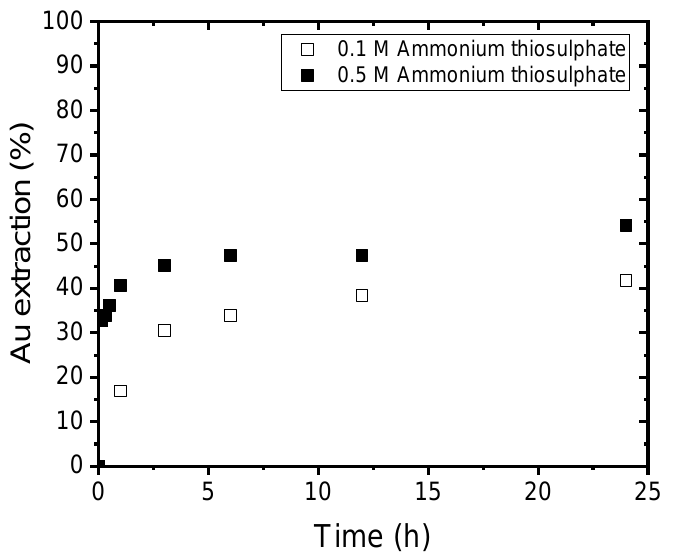
Figure 13. Effect of varying thiosulphate concentrations on gold extraction for Sample 1 at 0.5 M NH 3 and 1 mM Cu (30% solids, −300 + 150 µm PSD, 26 °C).